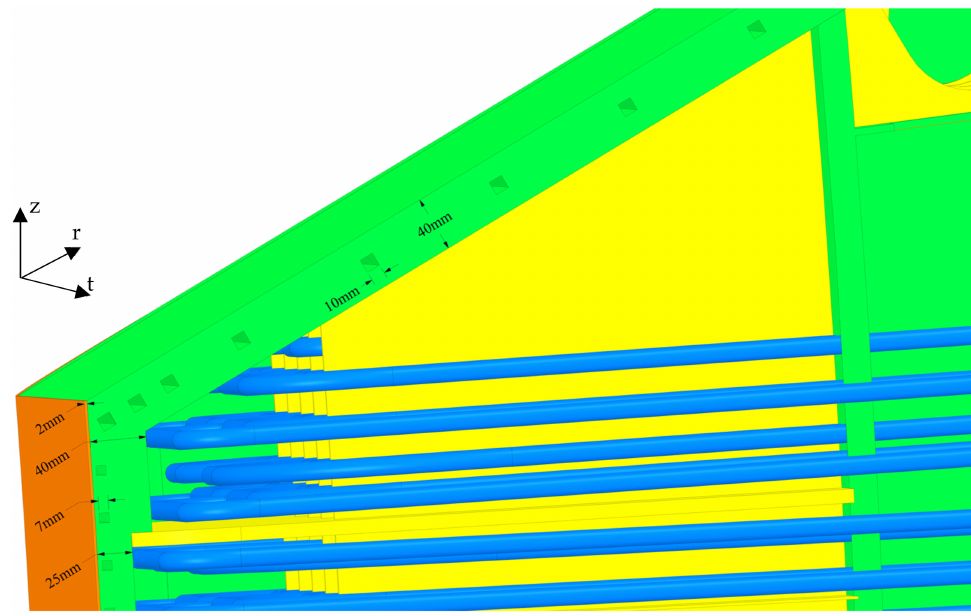
Figure 11. The “TC region-mod+” geometric